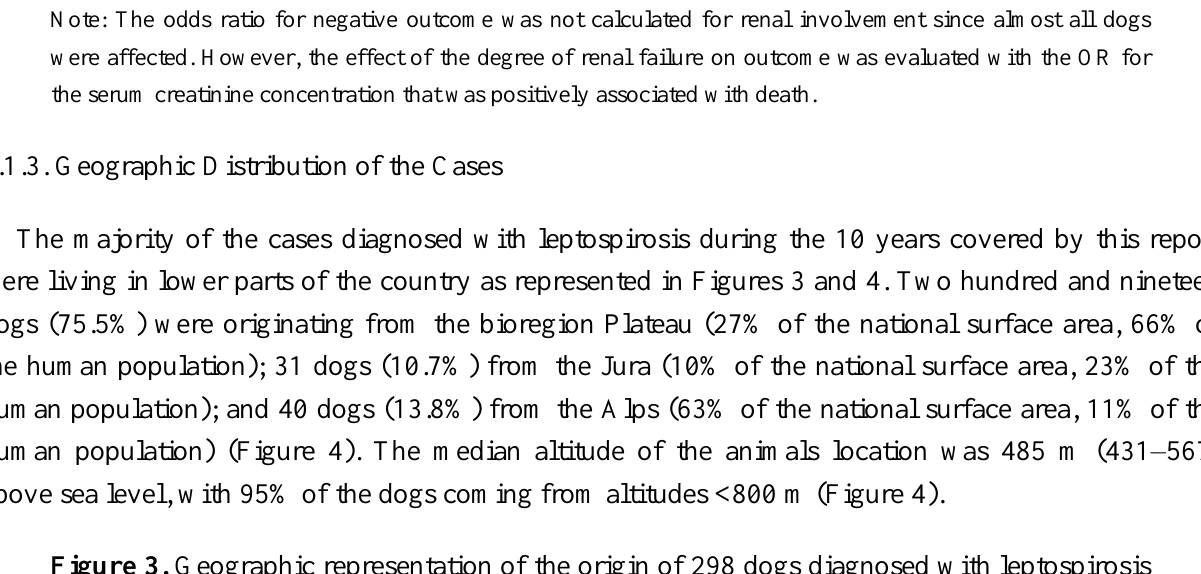
Figure 3. Geographic representation of the origin of 298 dogs diagnosed with leptospirosis (2003–2012) and their localization in the three main bioregions of